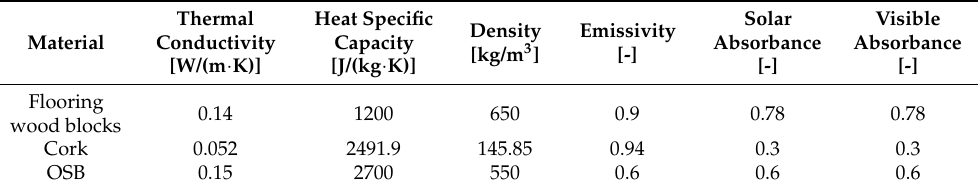
Table 3. Thermo-physical and optical properties of the materials used for assembling the floor.